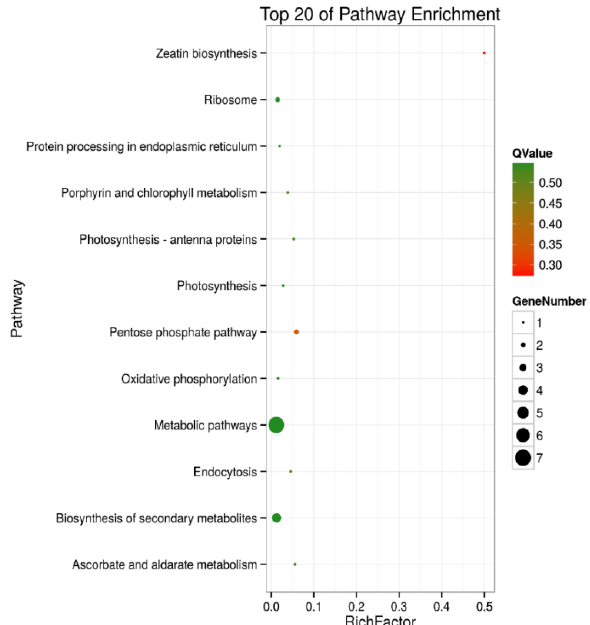
Figure 6. Top 20 pathway enrichments of DEPs in shoots of salt-treated sugar beet plants compared with controlled plants. The Y -axis indicates the KEGG pathway, the X -axis indicates the rich factor. The dot size indicates the number of DEPs of the pathway, and the dot color indicates the Q -value. Rich factor indicates the number of differentially abundant proteins participating in a KEGG pathway as a proportion of proteins involved in the pathway in all identified proteins. A P -value less than 0.05 was defined as statistically